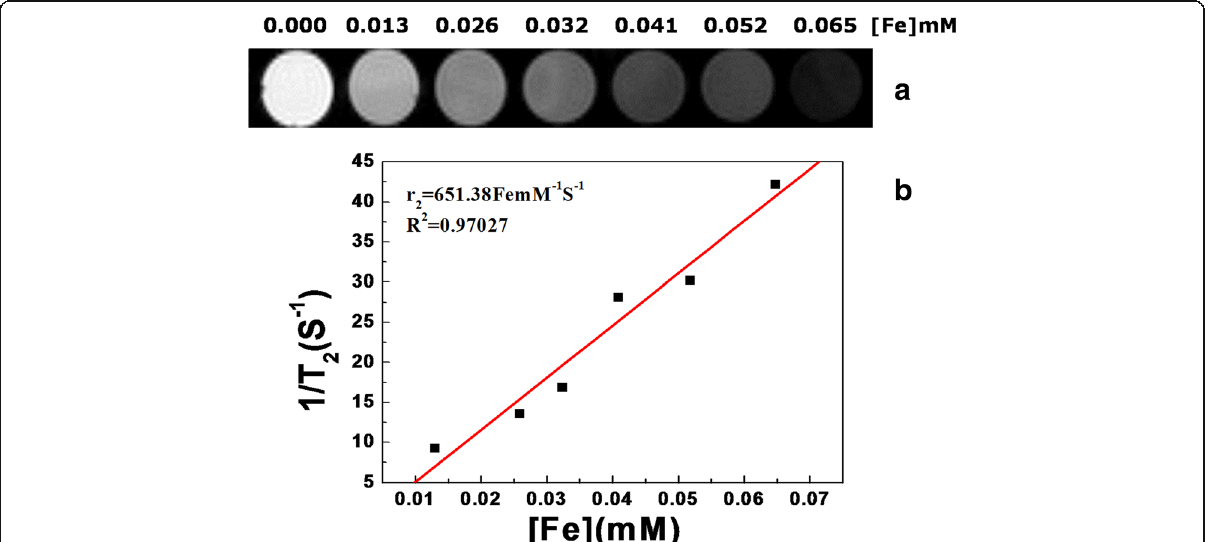
Fig. 3 a T 2 -weighted MRI images of the Fe 3 O 4 NC/PAH/PSS hybrid nanostructures at different concentrations in water. b Plot of relaxation rate r 2 versus Fe concentration in Fe 3 O 4 NC/PAH/PSS hybrid nanostructures. The relaxivity value the experimental